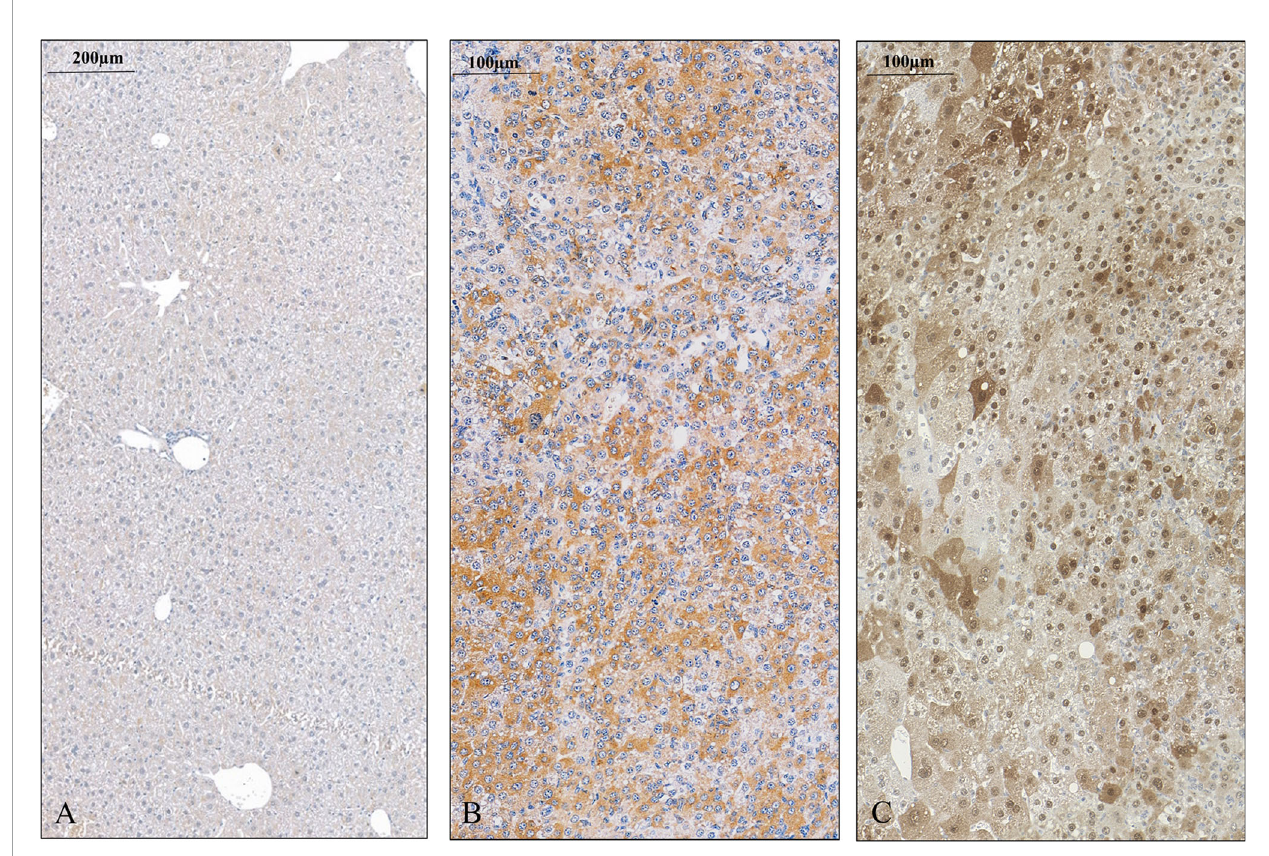
FIGURE 3 | SPOCK1 expression in control mouse liver and hepatocellular cancer. (A) Healthy liver with low amounts of SPOCK1 around the central veins. (B) SPOCK1 detection in diethylnitrosamine (DEN) induced hepatocellular cancer and transformed liver cells that contain ample amounts of proteoglycan. (C) Expression of CHD1L, the transcription factor of SPOCK1, in the same liver. The protein is detectable in both the nucleus and the